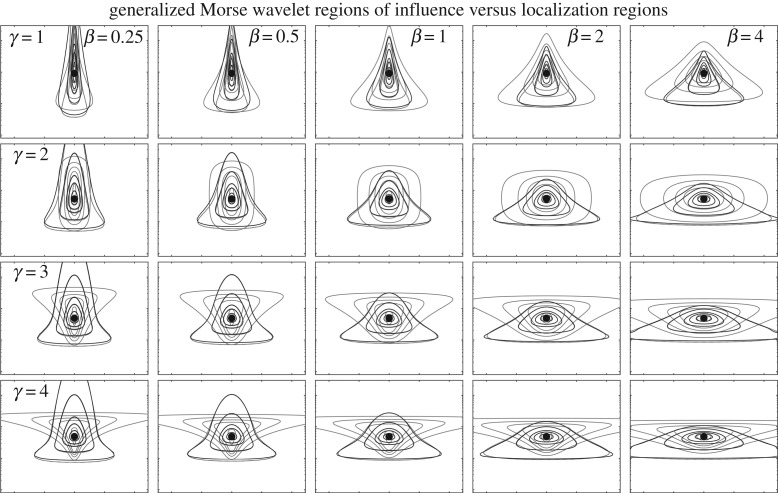
Regions of influence for the wavelet transform of a (0,γ) Morse function, transformed by Morse wavelets in the same γ family, compared with the Morse wavelet localization regions. Here, rows correspond to four different γ values, and columns to five different β values of the analysing wavelet, as labelled; this is just as in figure 2. The element function is ψ0,γ(t/ρ), with ρ chosen such that the element function scale frequency is ω0,γ/ρ=2π/100. Regions of influence for five different λ-values are shown: λ=0.25, 0.5, 0.75, 0.85 and 0.95, with the higher values being closer to the centre of each plot. Solid black lines are the actual λ-contours from the numerically computed wavelet transform, while dotted black lines show the approximations based on the second-order cumulant expansion given in (4.21); these are generally visually identical apart from the outermost curve at λ=0.25. Thin grey lines show the localization regions, described in the text, of a wavelet having scale frequency ωs=2π/100, with the area parameter Aβ,γ taking on the values of 1, 10, 20, 40 and 100. The axis limits are the same for each subplot. The x-tick marks are at times τ=−200, −100, 0, 100 and 200, while the major y-tick marks are at scale frequencies ωs=1/100, 1/10 and 1. Note that the y-axes are logarithmic.